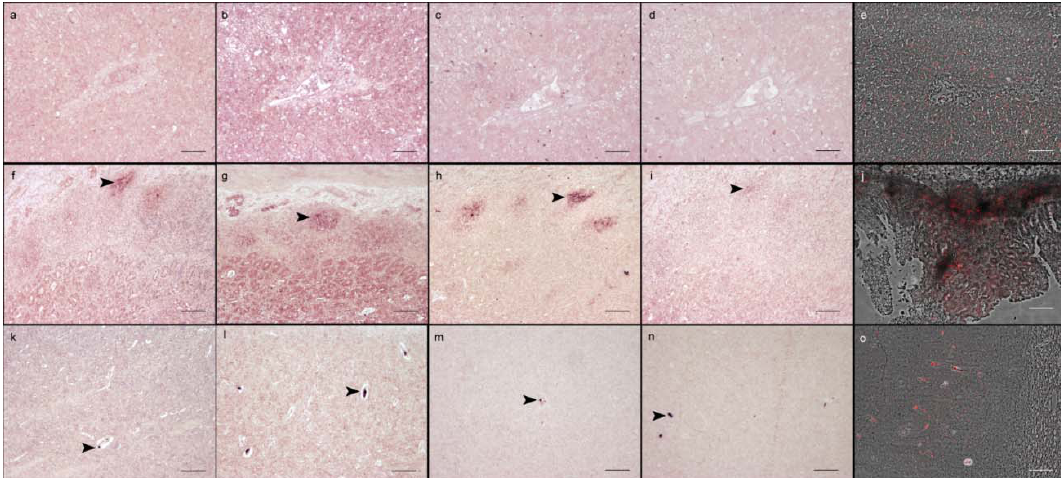
Figure 3. Comparison of the signals detected, using three different methods in an EqHV-infected horse, a CBoV-2-positive dog, and a PCV-2-infected pig. The arrowheads indicate a positive signal in the figures displaying the results of ISH using a DIG-labelled probe. ( a ) The self-designed sense DIG-labelled EqHV RNA probe failed to detect viral nucleic acid (bar: 100 µ m); ( b ) The anti-sense DIG-labelled RNA probe was also not able to detect EqHV-specific nucleic acids within hepatocytes (bar: 100 µ m); ( c ) Using the ordered sense DIG-labelled RNA probe, no signal was detectable in the liver of an EqHV-infected horse (bar: 100 µ m); ( d ) The ordered anti-sense DIG-labelled RNA probe also failed to detect an EqHV-specific signal (bar: 100 µ m); ( e ) The FISH-RNA probe mix was able to detect EqHV in several hepatocytes (bar: 100 µ m). ( f ) The self-designed CBoV-2-specific RNA sense probe showed multifocal positive cells in submucosal lymphoid tissue of the small intestine (bar: 100 µ m); ( g ) Similar results were obtained using the CBoV-2-specific RNA anti-sense probe (bar: 100 µ m); ( h ) Using the ordered DNA sense probe, submucosal lymphoid tissue of the small intestine stained positive for CBoV-2 (bar: 100 µ m); ( i ) The DNA anti-sense probe was also able to detect CBoV-2 in the submucosal lymphoid tissue of the small intestine (bar: 100 µ m); ( j ) The FISH-RNA probe mix revealed a strong signal detecting CBoV-2-specific nucleic acids in the submucosal lymphoid tissue of the small intestine (bar: 100 µ m); ( k ) Single endothelial cells of the cerebrum stained positive for PCV-2 in a PCV-2 infected pig using the self-designed RNA sense probe (bar: 100 µ m); ( l ) Similar results in single endothelial cells were obtained using the anti-sense probe on the cerebrum of the same animal (bar: 100 µ m); ( m ) The ordered DNA sense probe was also able to detect PCV-2 in cerebral endothelial cells in this animal (bar: 100 µ m); ( n ) Additionally, the DNA anti-sense probe revealed a positive PCV-2 specific signal in single endothelial cells of the porcine cerebrum (bar: 100 µ m); ( o ) The FISH-RNA probe mix showed a PCV-2 specific signal in several endothelial cells of the cerebrum of this pig (bar: 100 µ